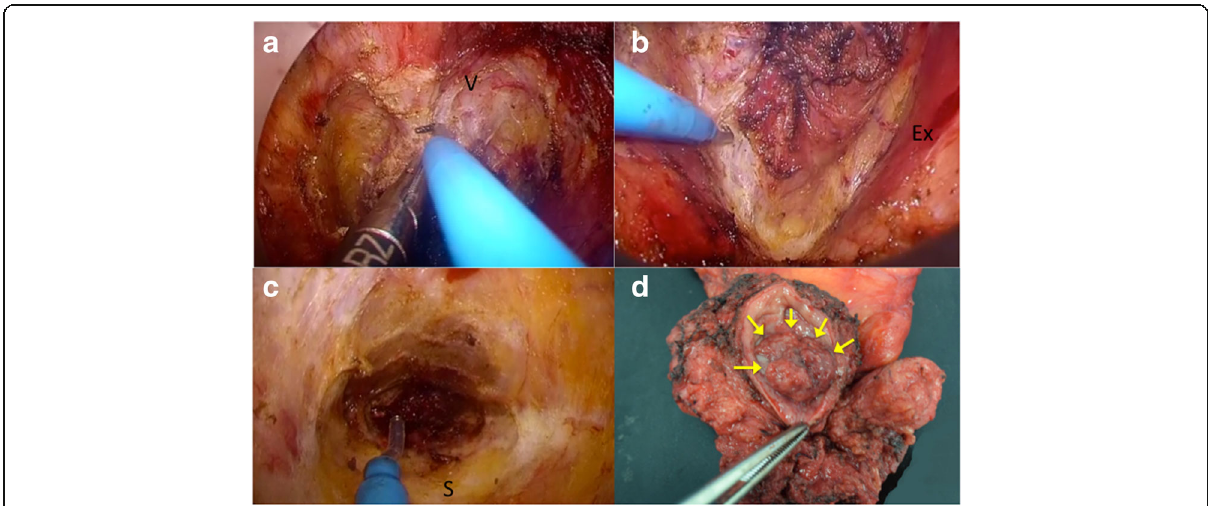
Fig. 2 Intraoperative views under the transanal endoscopic approach (TEA). a Dissection between the vagina and the rectum. V vagina. b Dissection of the external sphincter muscle. Ex external sphincter muscle. c Dissection of the scar tissue on the sacrum. S sacrum. d The recurrent tumor is located in the vaginal stump, indicated by yellow